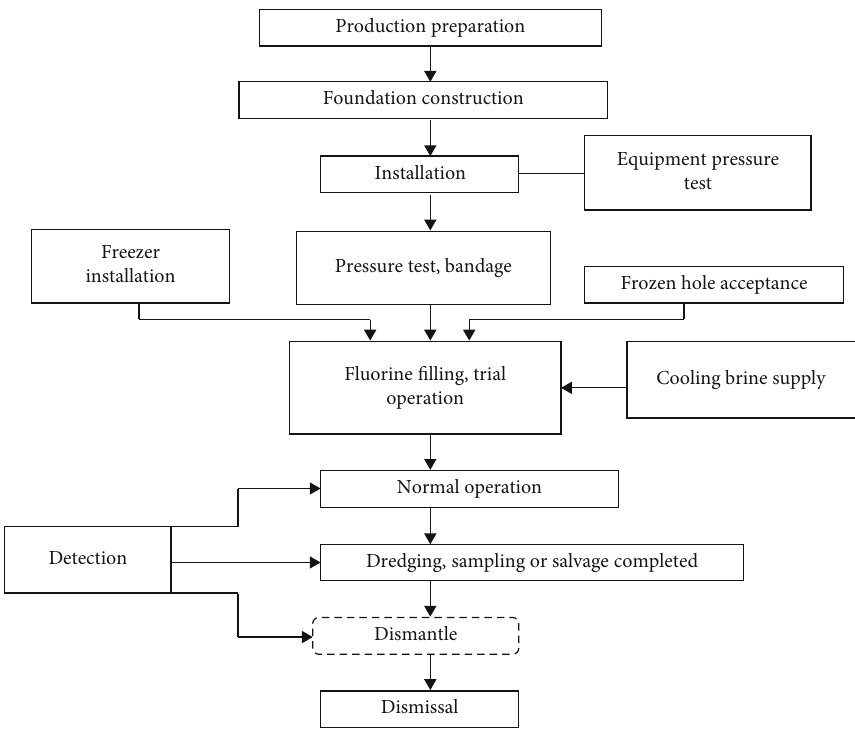
Figure 2: Flowchart for the AGF